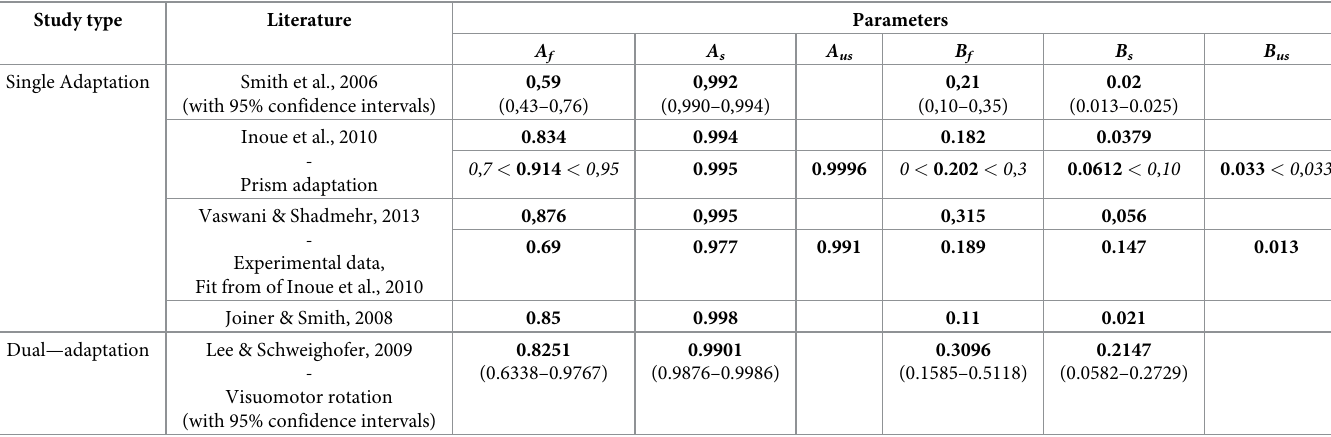
Table 2. Overview of relevant literature for parameter